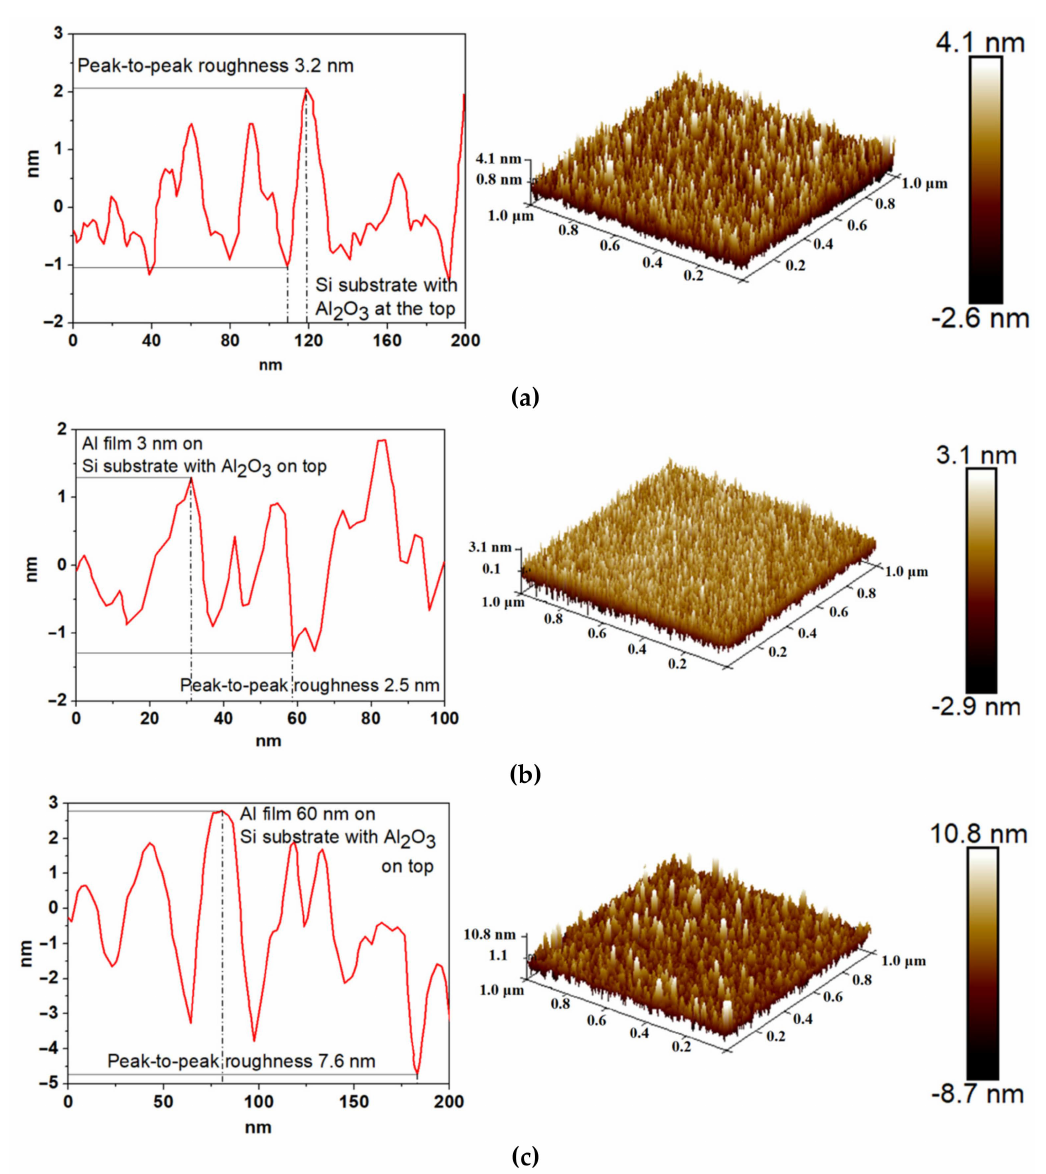
Figure 2. ( a ) Si substrate with Al 2 O 3 at the top. Profile of this substrate. Peak-to-peak roughness of 3.2 nm; ( b ) Al film of 3 nm on the top of this substrate. Profile of this film. Peak-to-peak roughness of 2.5 nm (less compared to substrate); ( c ) Al film of 6 nm on similar substrate. Profile of this film; peak-to-peak roughness of 7.6 nm. Al and Al 2 O 3 films were fabricated by magnetron